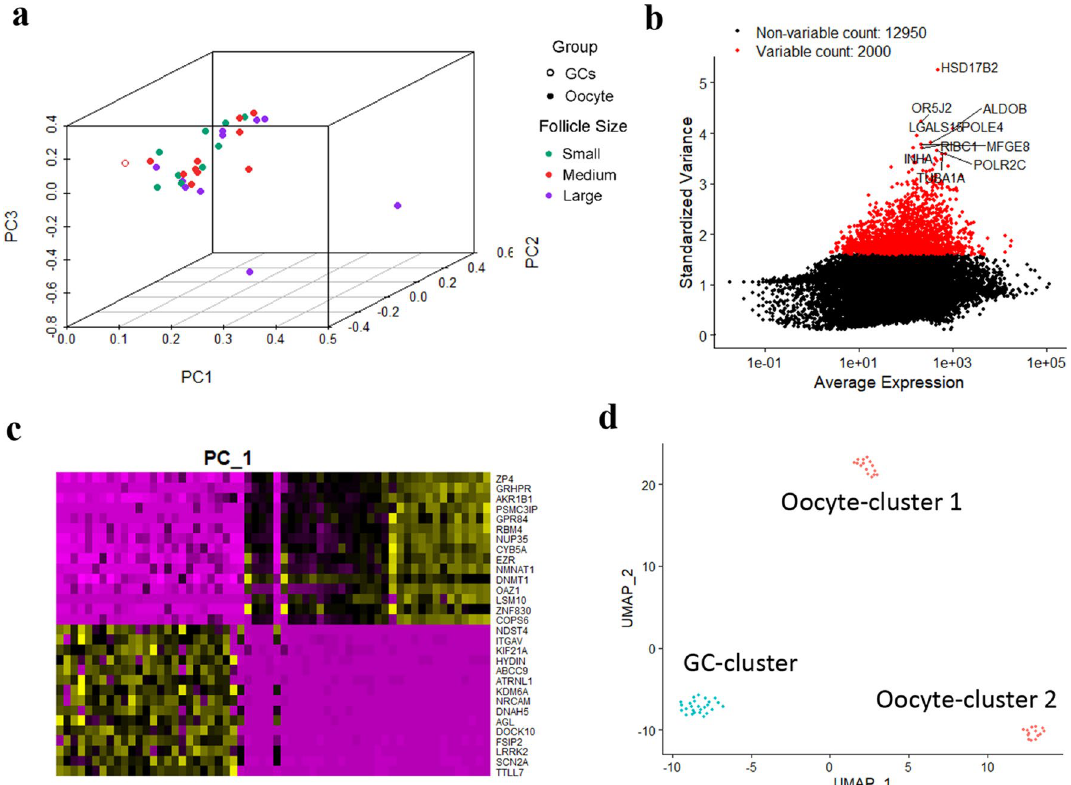
Figure 1. The global transcriptomic character of oocytes and granulosa cells in Jining grey goat. ( a ) 3D PCA plot of oocyte and granulosa cell (GCs) samples. ( b ) Highly variable genes of samples identified by Seurat (top 10 with label). ( c ) Genes in PC1 identified by Seurat. ( d ) UMAP cluster of oocyte and granulosa